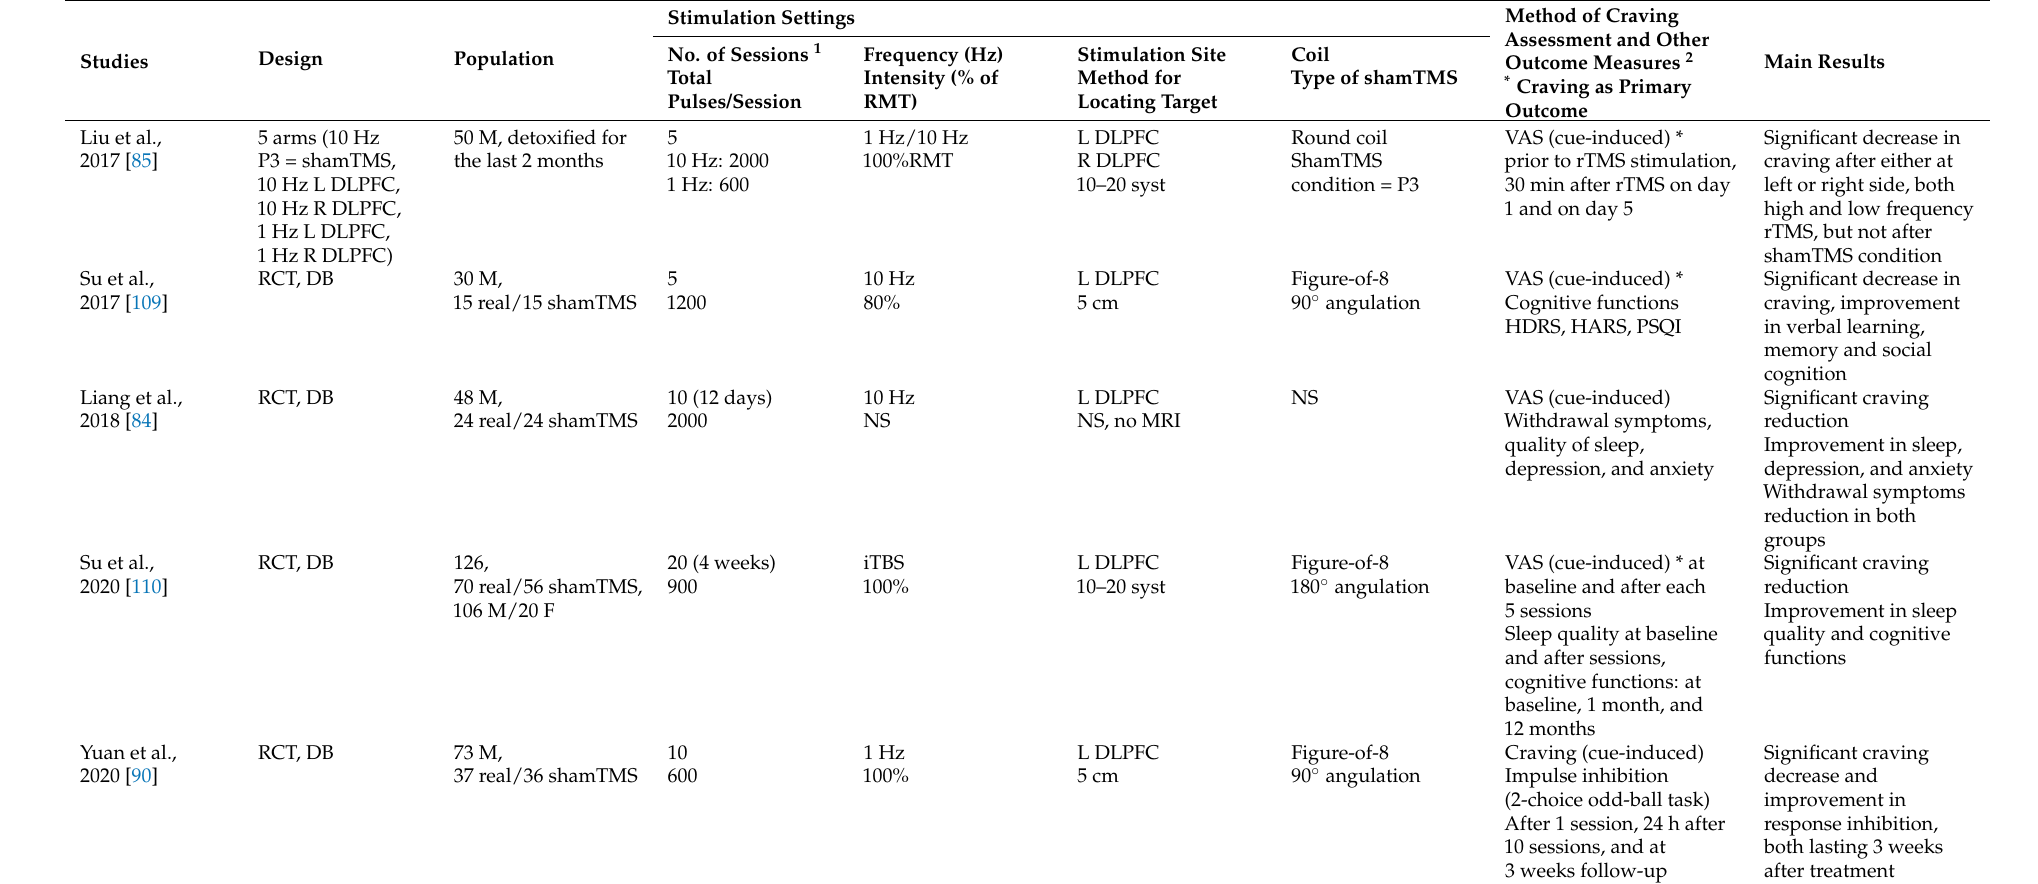
180 ◦ angulation Figure-of-8 90 ◦ angulation